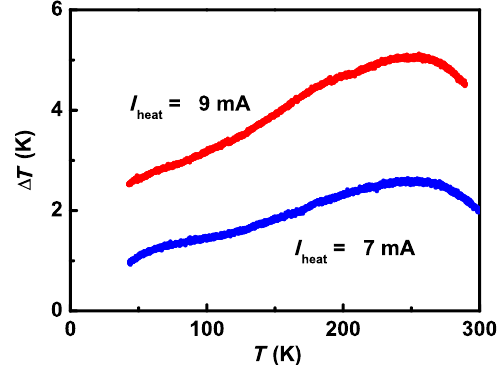
7. The calculated Δ T across the Pt/Cu/YIG hybrid structure as a function of system temperature. Two curves are illustrated under heating currents of 7 and 9 mA,